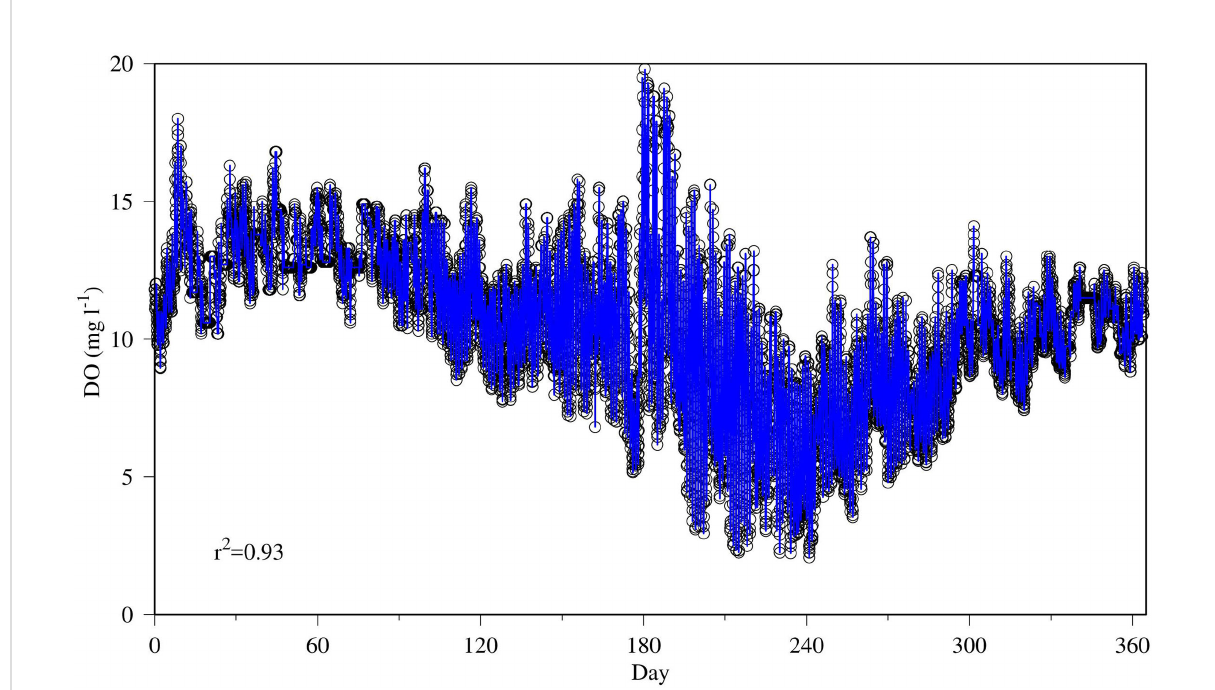
FIGURE 9 Generalized Additive Model (GAM) prediction (blue line) of DO simulation time-series data (black circles) at the upper estuary station XHH3851 using the same prediction variables used in the CART analysis (Figure